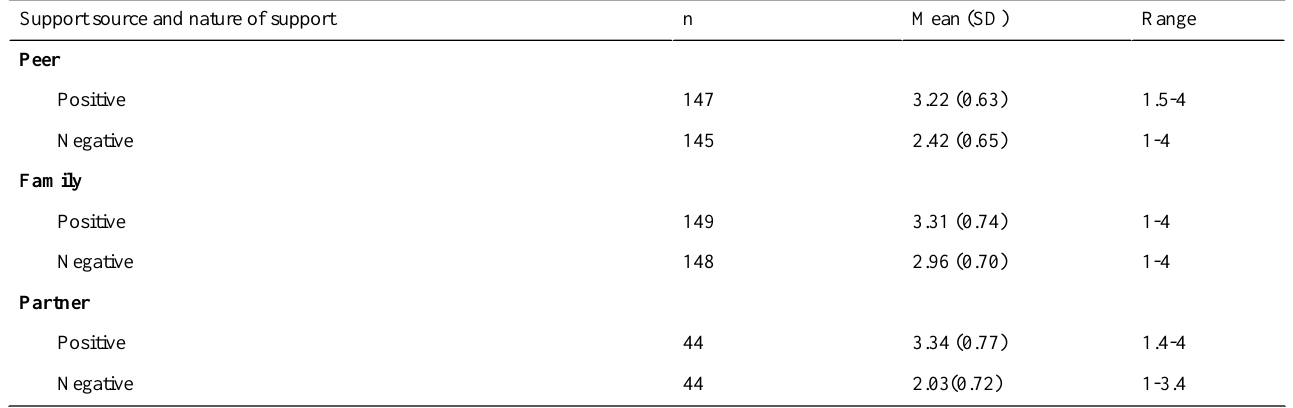
Table 3. Social support levels within the sample.